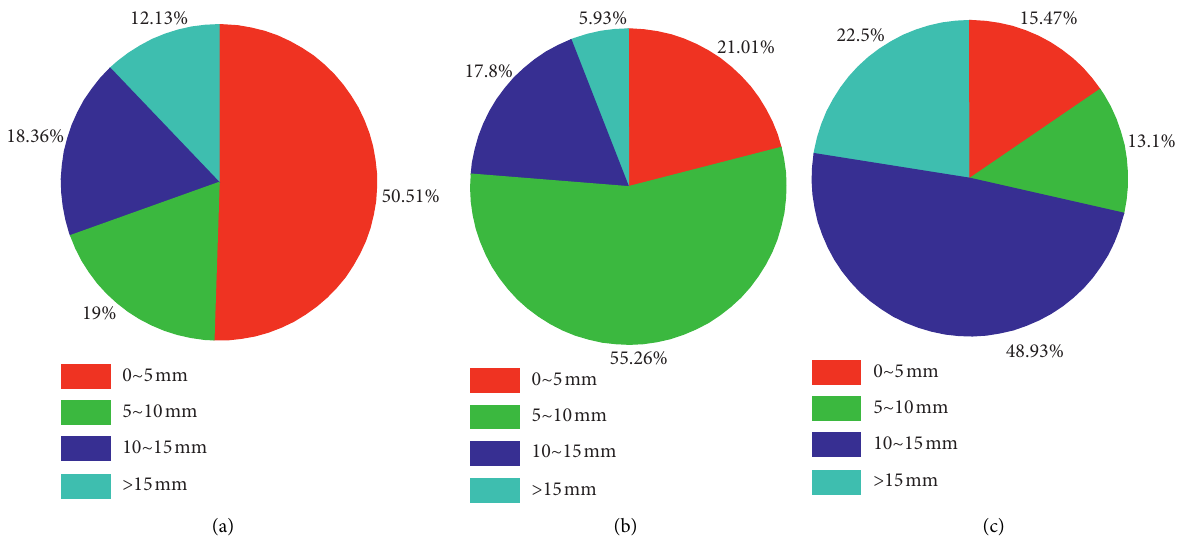
Figure 8: Fragment (chip) weight distributions of CGFB after failure. (a) Group A (0 ∼ 5 mm). (b) Group B (5 ∼ 10mm). (c) Group C (10 ∼ 15